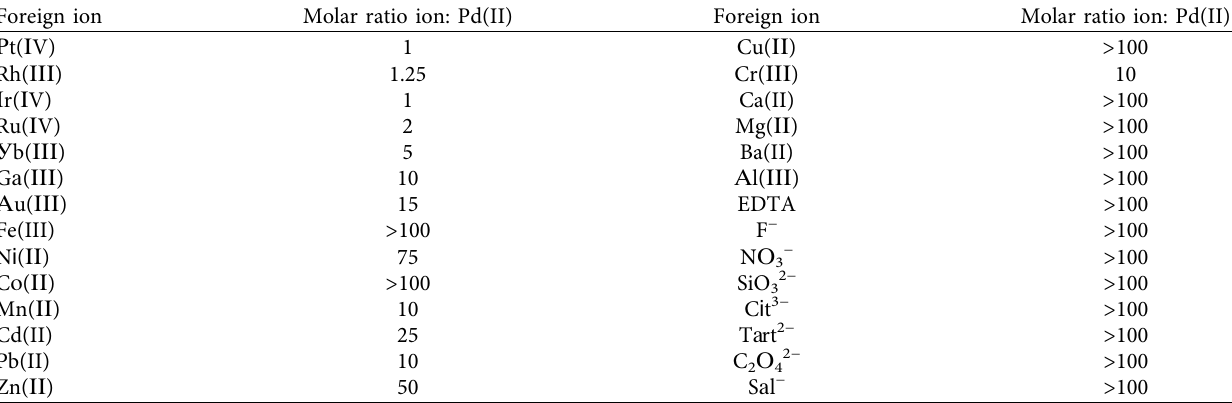
− 5 mol · L − 1 ; S � 7.50 · 10 − 5 mol · L − 1 R d( __ ) � 2.50 · 10 p -ITYBA